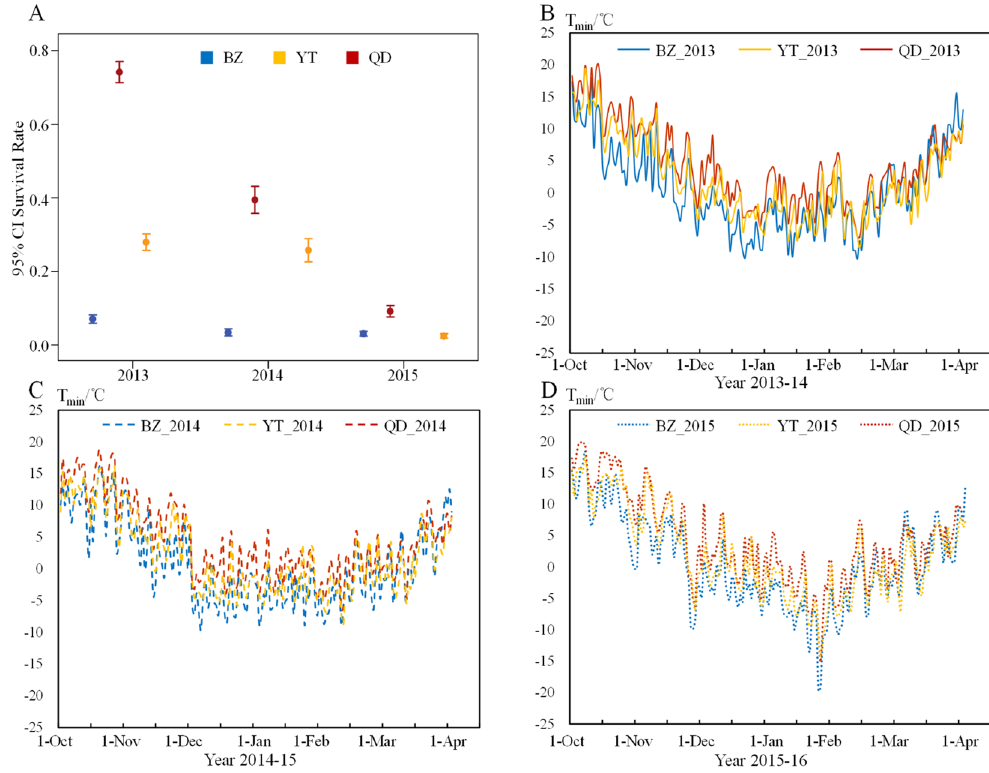
Figure 1. Mean survival rate (SR) of 672 pea accessions at three locations and three growing seasons ( A ) and daily lowest temperature records at each experiment ( B – D ). Each growing season is drawn in a separate graph and the three locations are represented with different colors: BZ, blue; YT, yellow; and QD,